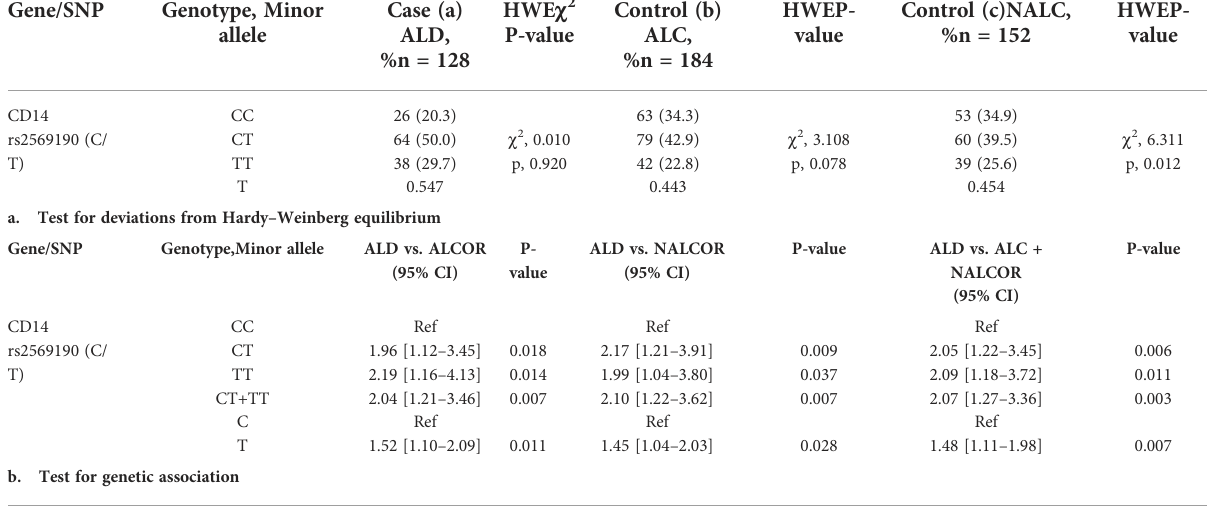
TABLE 2 Frequency distribution for CD14 gene SNP (rs2569190) genotype/minor allele and its genetic association for Alcoholic liver